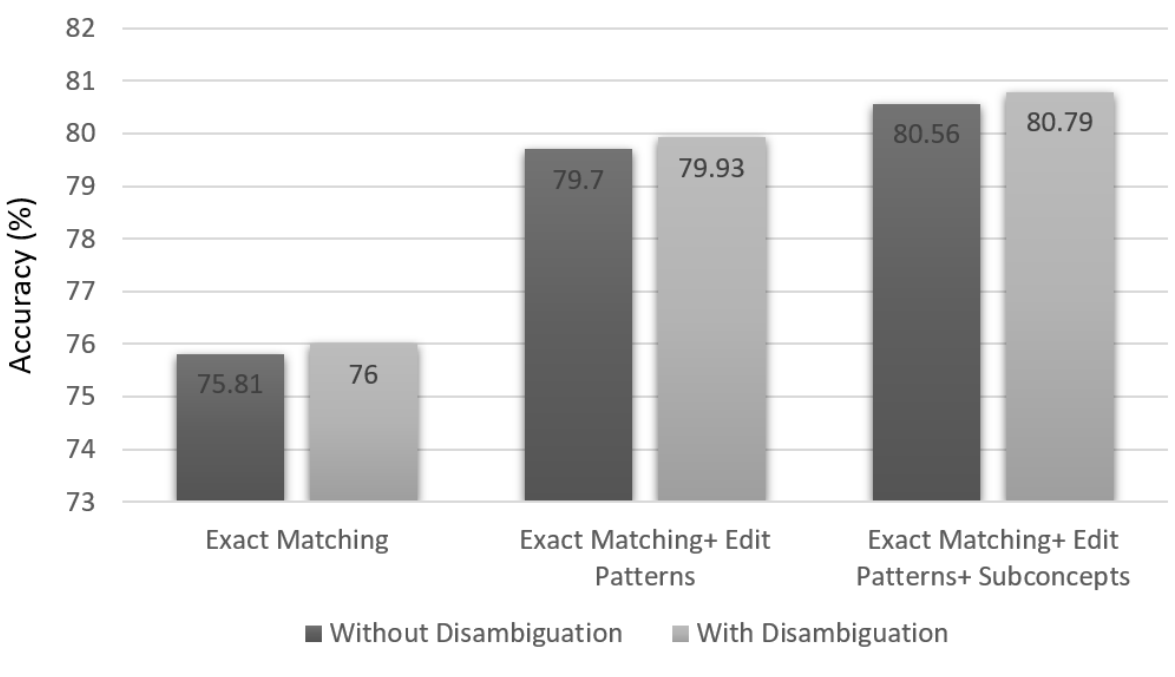
Figure 4. Accuracy (%) of the system on the Medical Concept Normalization data set evaluated by incrementally adding the normalization components with and without the disambiguation